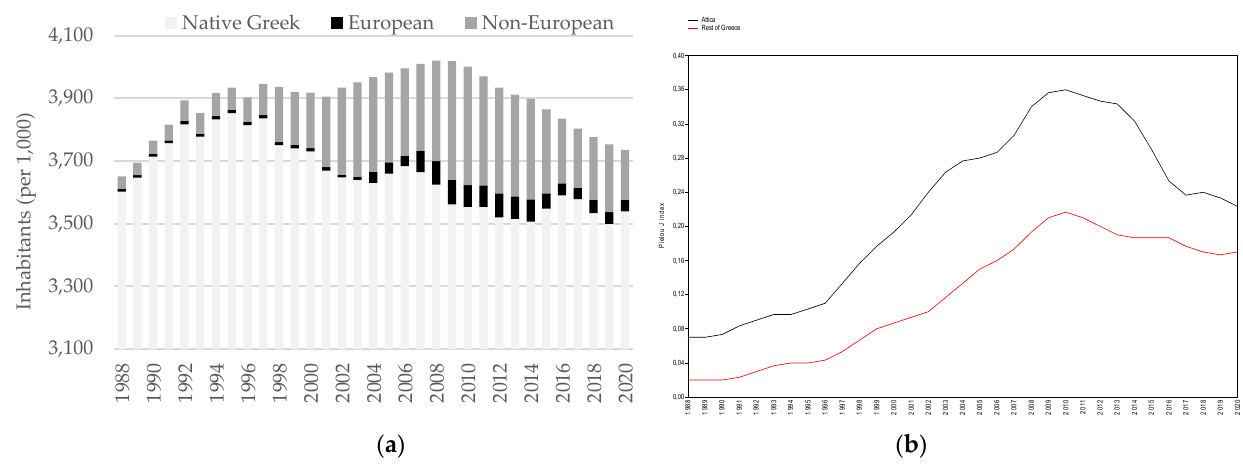
Figure 2. ( a ) The evolution of total population by citizenship over time in Attica, 1988–2020 (the ‘European’ class excludes all native ‘Greek’ citizens); Labour Force Survey estimation, ELSTAT; and ( b ) Pielou J evenness index of diversification in population composition by place of birth comparing Attica and the whole of Greece over time (source: ELSTAT Labour Force Survey).